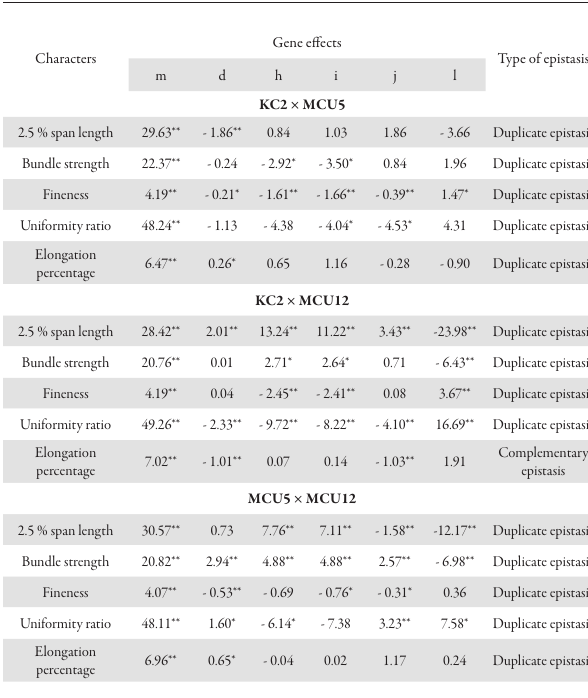
Tab. 2. Gene effects and type of epistasis (gene interaction) for fibre quality characters